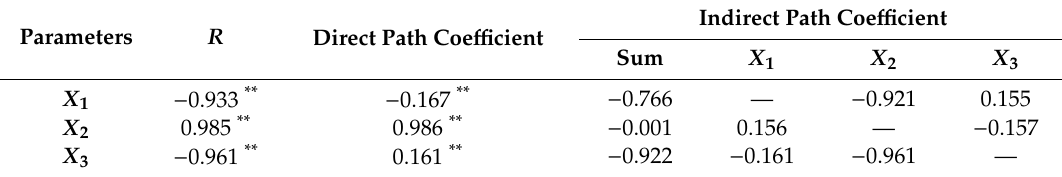
Table 3. Path analysis results of the influencing factors on anthocyanin content.